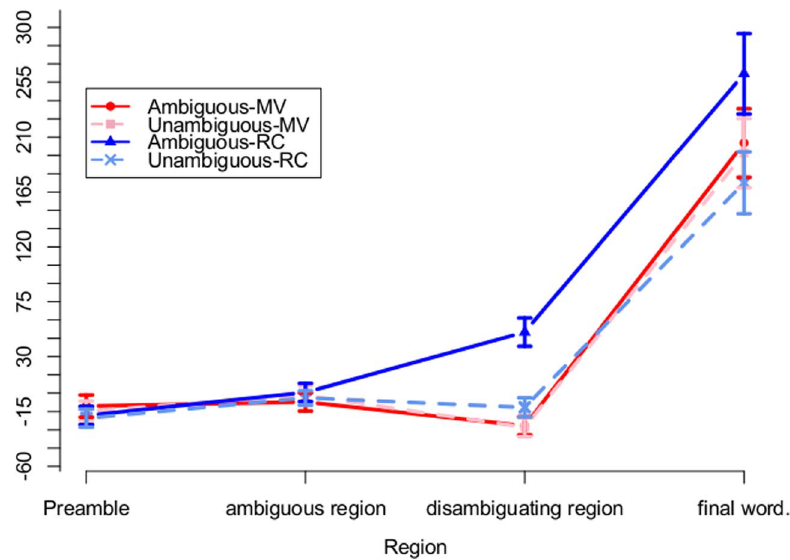
Figure 4. By-region reading times for Experiment 1. Mean length-corrected reading times at each sentence region (indicated in (2)) for all conditions in Experiment 1. Error bars represent 95% confidence intervals on the mean.